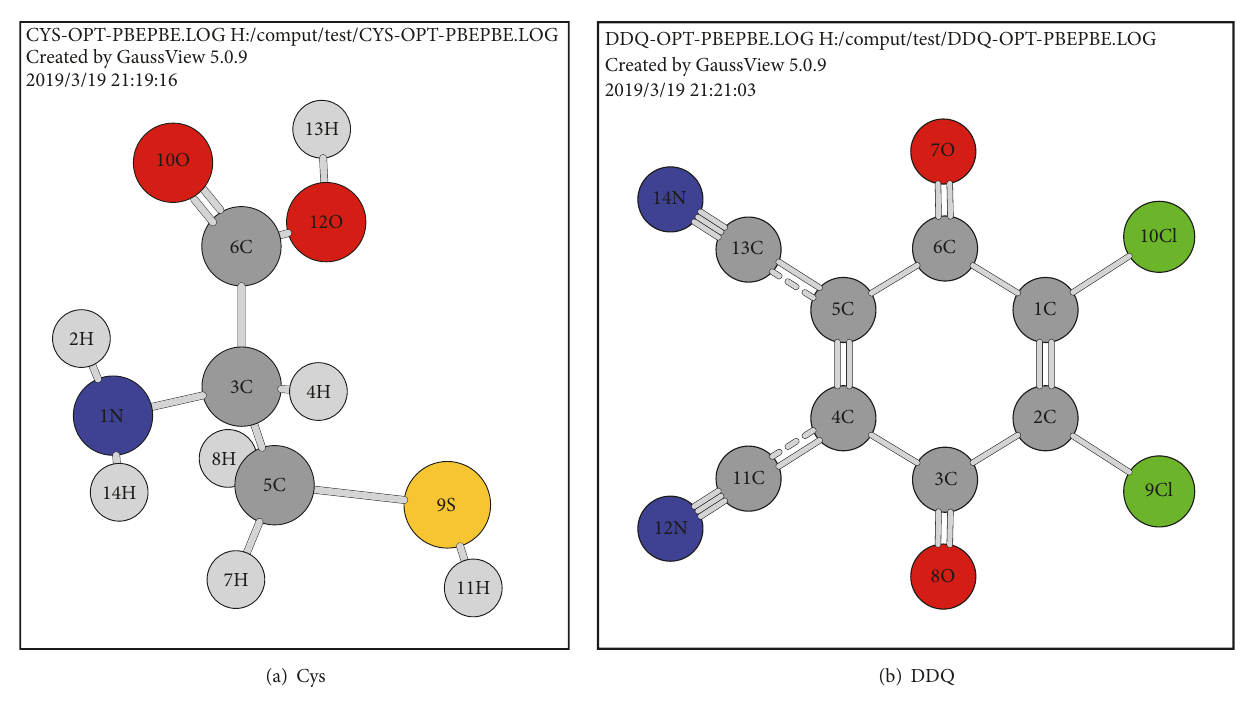
Figure 4: The optimized structures of Cys (a) and DDQ